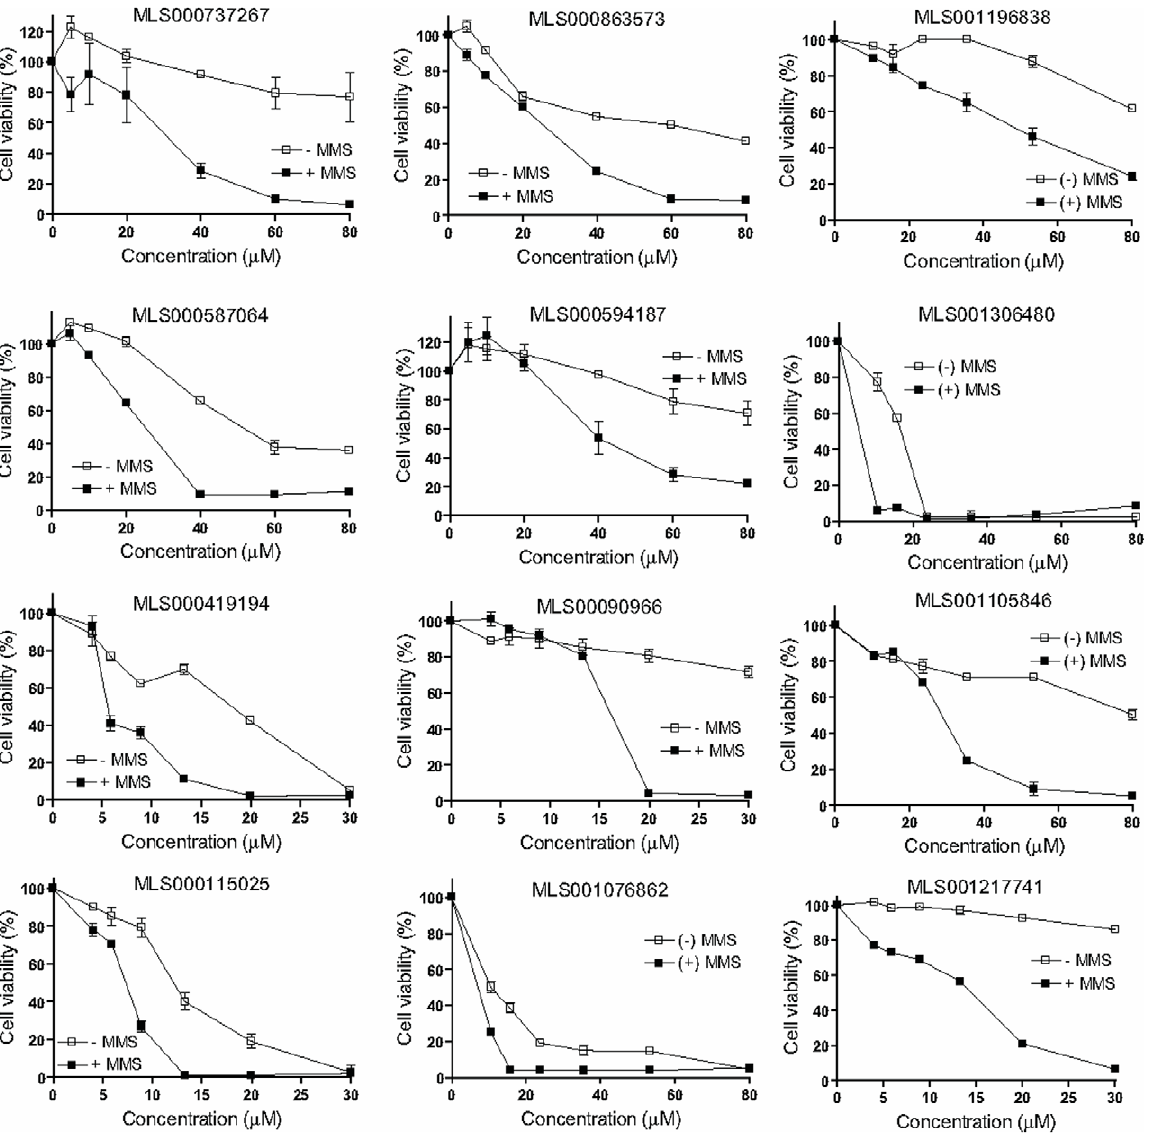
Figure 5. Significant potentiation of the genotoxic effect of MMS by 12 prioritized hits (designated P in Table S1). HeLa cells were exposed to a dilution series of each compound shown in the absence (empty squares) and presence of 400 m M MMS (filled squares), and after a 24- hour incubation the cell viability was measured by ATP-content detection using CellTiter Glo. Results are presented as averages and standard deviations from duplicate samples, normalized against